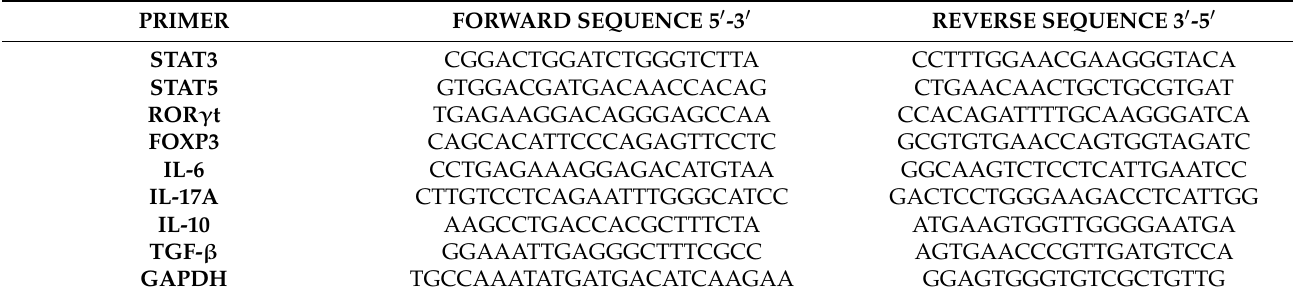
Table 1. Forward and reverse sequence of primers used for real-time